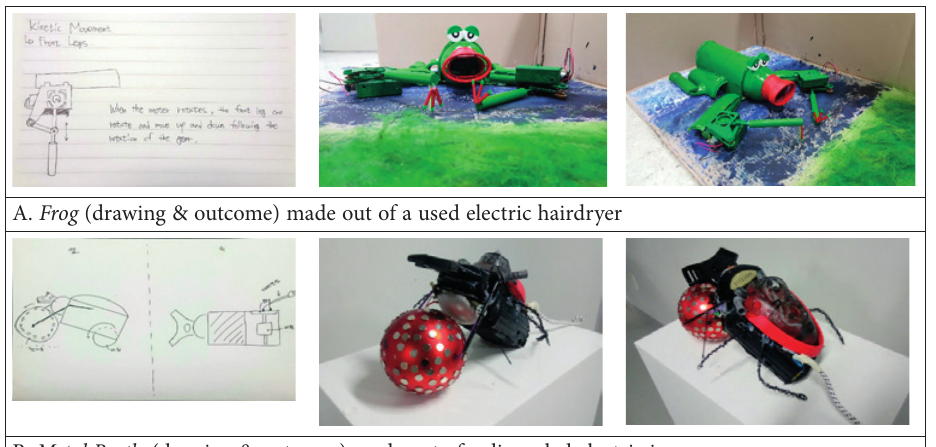
Table 6. Use of discarded household appliances (source: created by